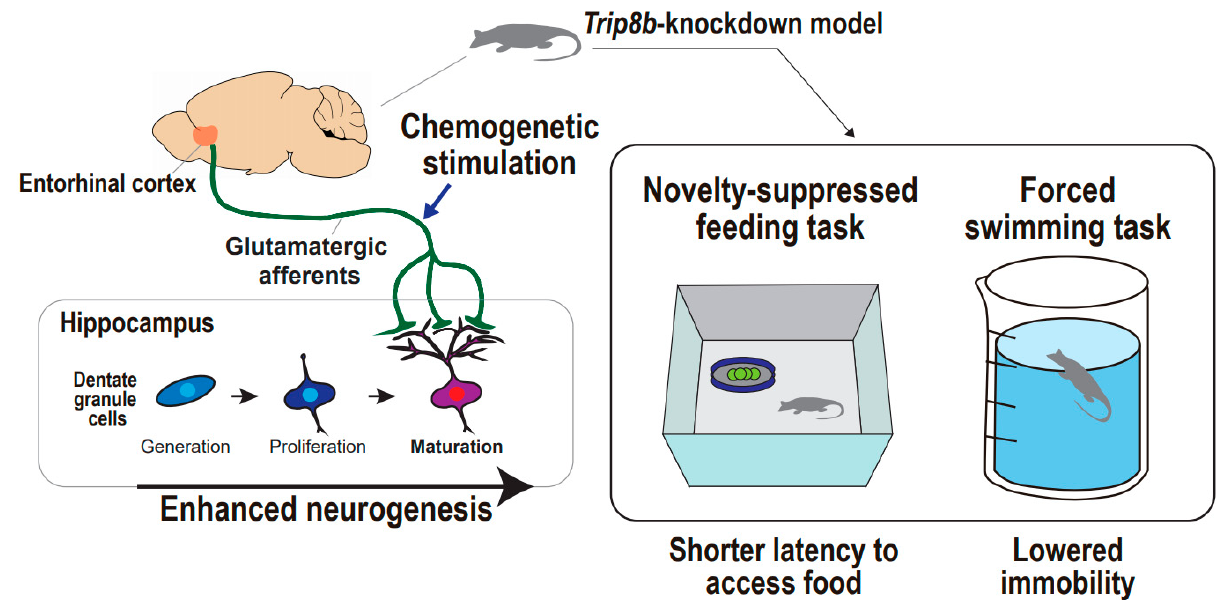
Figure 4. Supportive findings for entorhinal cortex-regulated hippocampal neurogenesis in the regulation of mood. Entorhinal–hippocampal circuitry and hippocampal neurogenesis in the regulation of animal mood. Chemogenetic stimulation of entorhinal cortex results in enhanced neurogenesis in Trip8b -knockdown mouse, which is accompanied by both shorter latency to access food in the novelty-suppressed feeding task and lowered immobility in the forced swimming